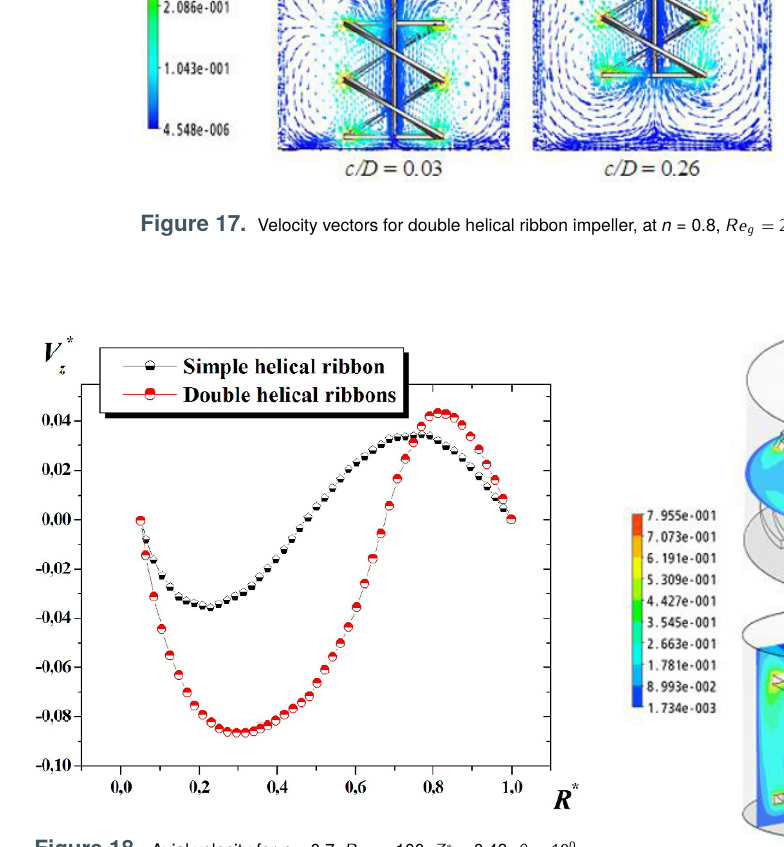
g = 100, Z ∗ = 0.43, θ = 10 0 . Figure 19. Flow fields at n = 0.7, Re g = 100 , (a) simple helical ribbon, (b) souble helical